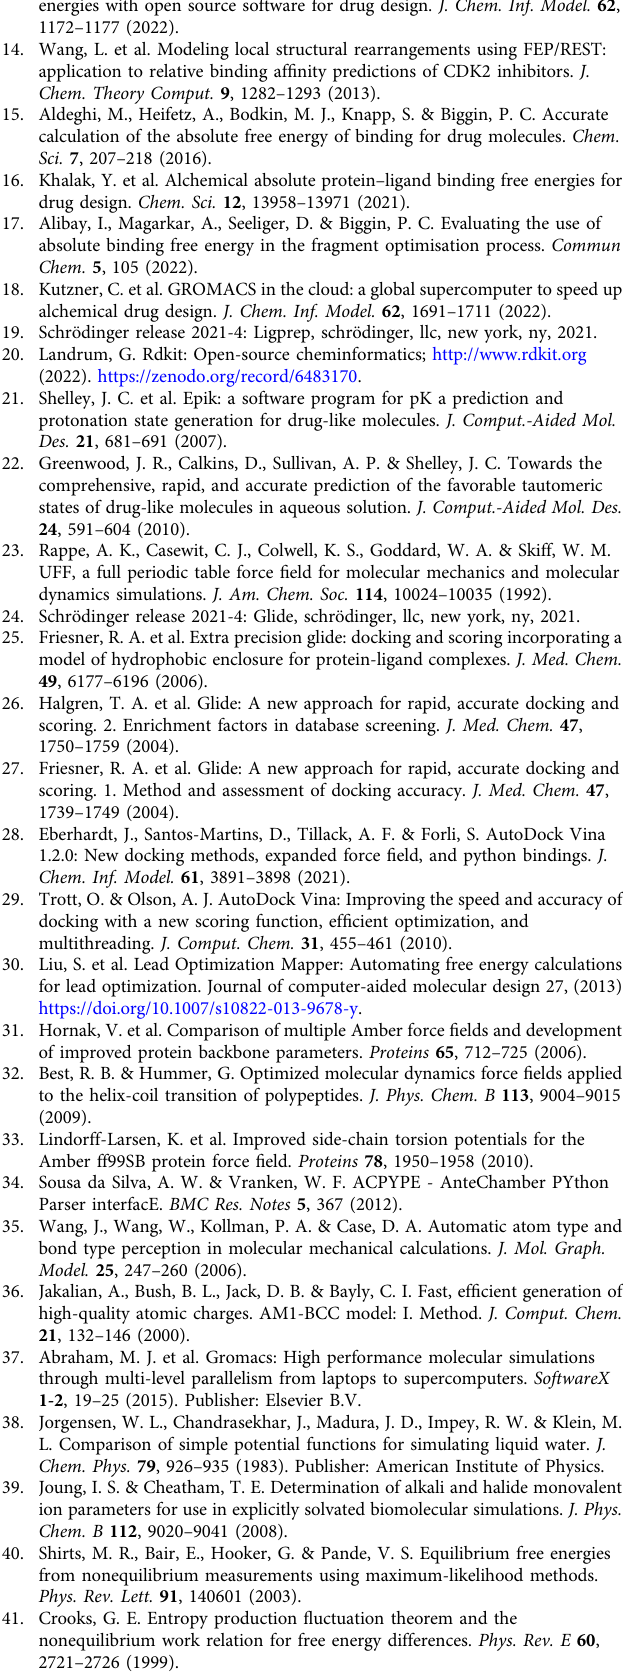
Table 1 Summary of systems studied in this